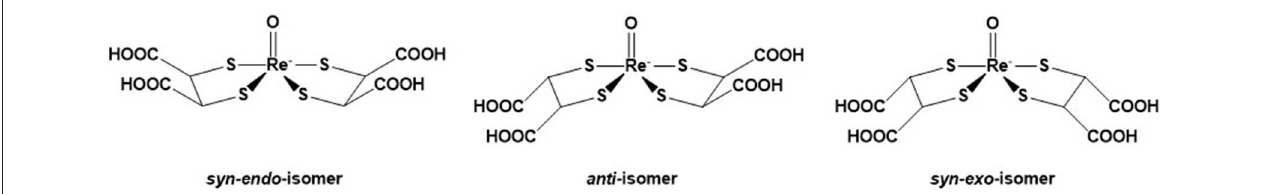
FIGURE 3 | 188 Re-DMSA isomers.